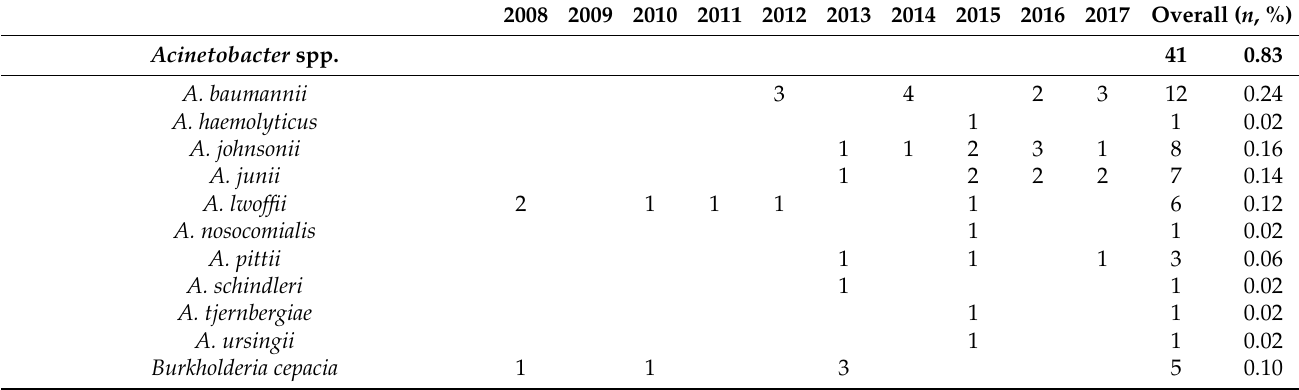
Table 2. Distribution of relevant pathogens from outpatient UTIs affecting elderly patients (2008–2017).